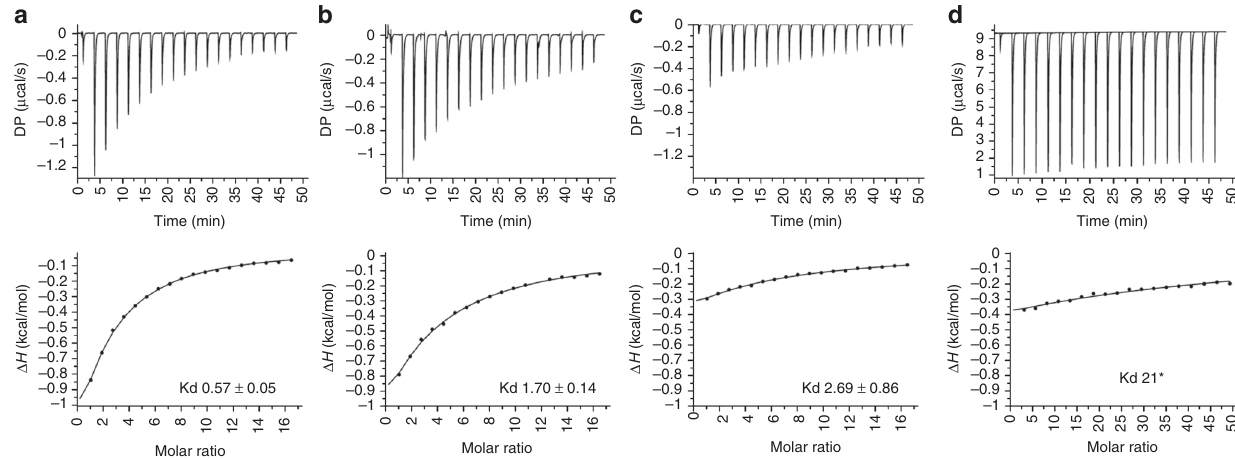
Fig. 6 ITC isotherms of Rg CBM40 to sialoglycans. a Rg CBM40 binding to 3 ′ SL, b Rg CBM40 binding to 6 ′ SL, c Rg CBM40 binding to 3 ′ SLGc, d Rg CBM40 binding to Neu5Ac. The Kd is indicated in mM. *This value is an estimate as the Kd is too high to determine with the concentration of sugar